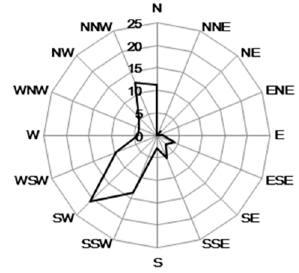
Figure 2. Air temperature and humidity during dust storm on 3–5 May, 2017 in Beijing. Figure 3. Frequency of wind direction during dust storm on 3–5 May, 2017 in Beijing.